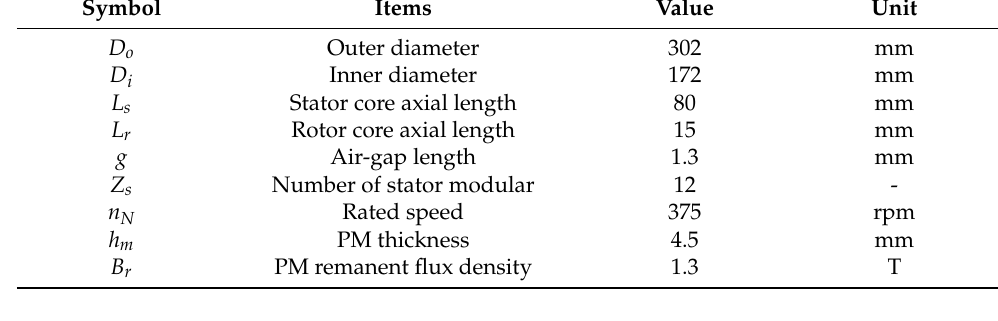
Table 1. Specifications of the proposed DR-HEAFPMVMs.